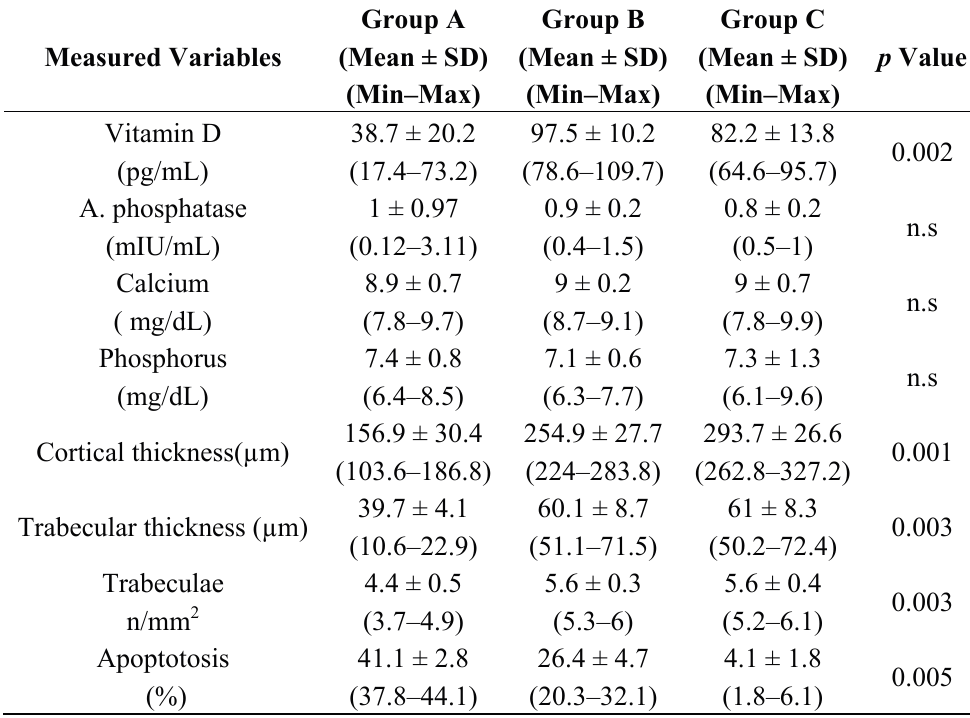
Table 1. Mean values and standard deviations of measured